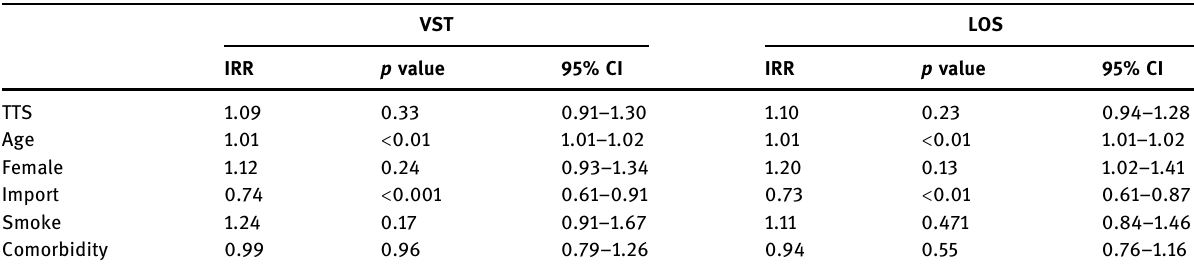
Table 2: Multivariate regression on LOS and